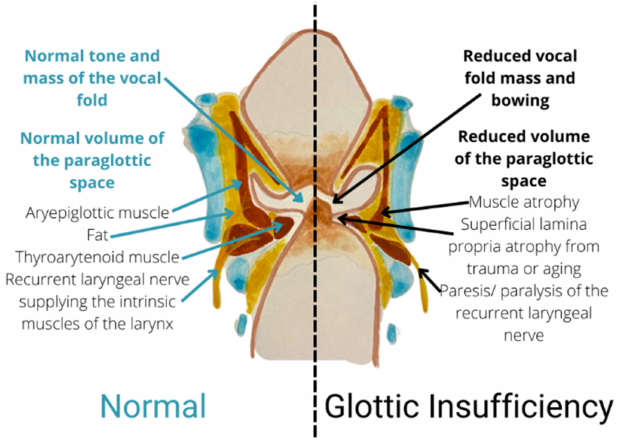
Figure 2. Coronal section showing a comparison between normal condition and glottic